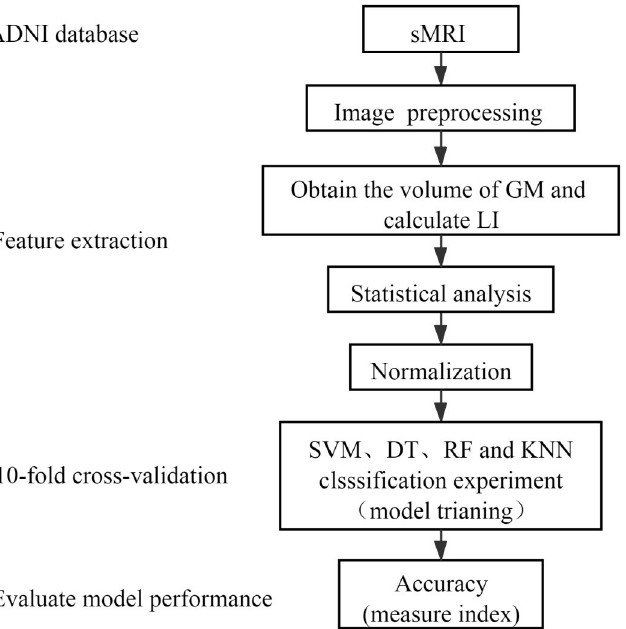
Fig 1. The classification algorithm flow chart for binary classification among NC, EMCI, LMCI and AD groups.